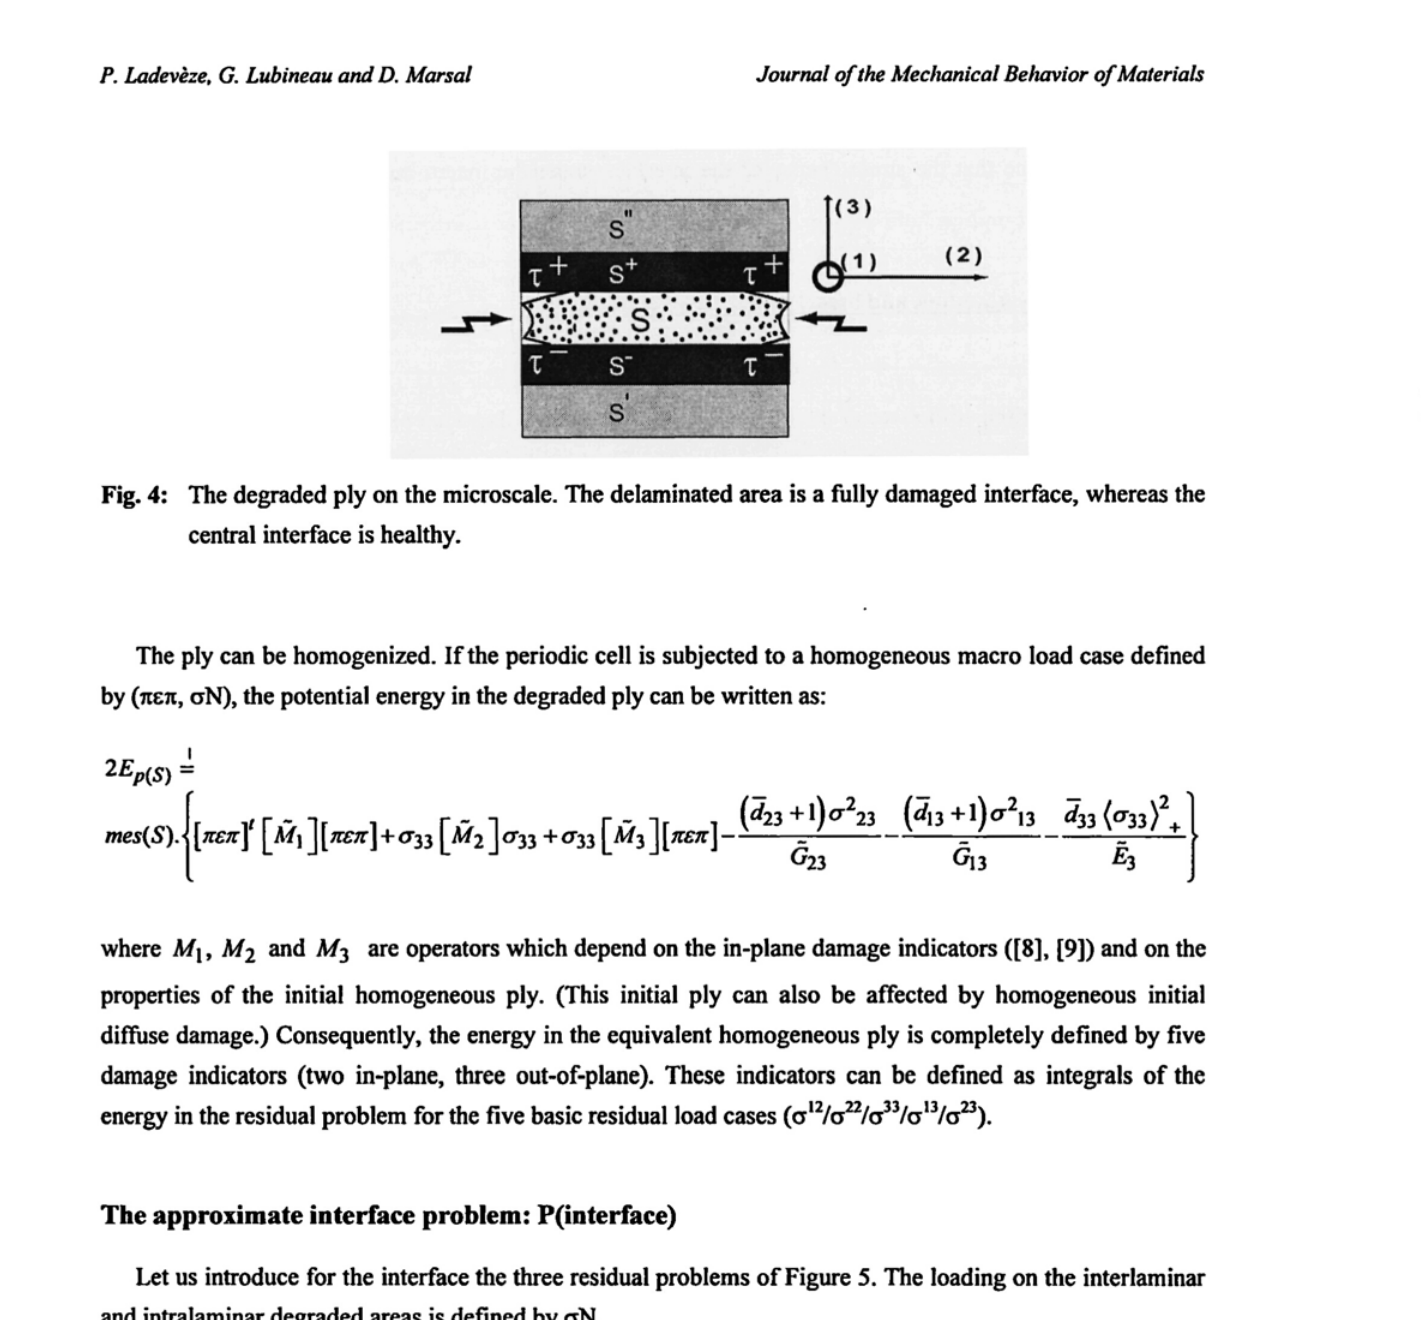
Fig. 5: The residual problems for the